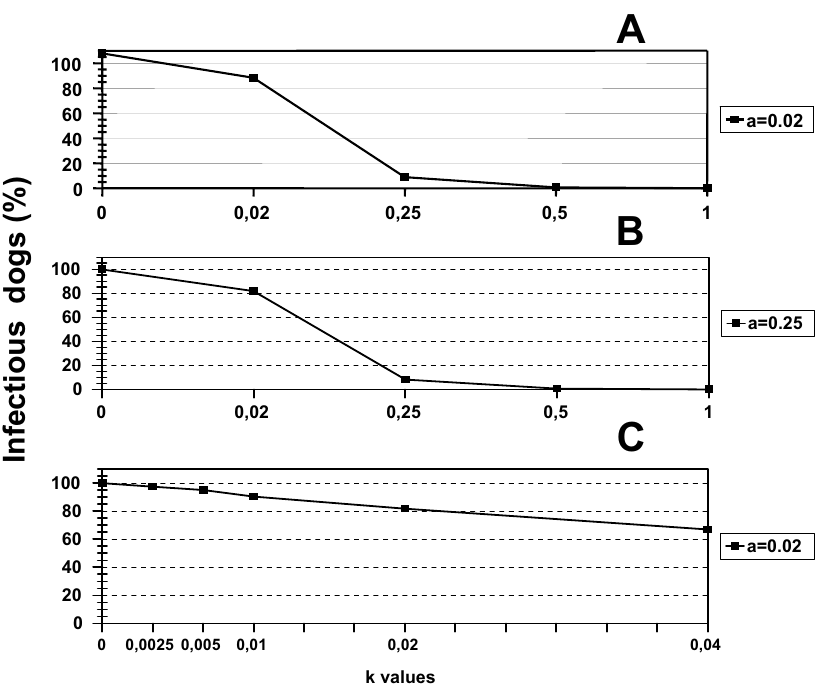
Fig. 1 – Variation of the infectious dog population in the field according to the κ values. The κ value represents the power of the control campaign ( x axis) on the removal of infectious dogs ( y axis). Considering an initial number of 2000 dogs, 30% of them already infected, the effect of κ value is analyzed, using an α D = 0 . 02 (Figure 1A) , and an α D = 0 . 25 (Figure 1B) . We also tested the model using the initial population composition of susceptible dogs (50%) at α D = 0 . 02 (Figure 1C)